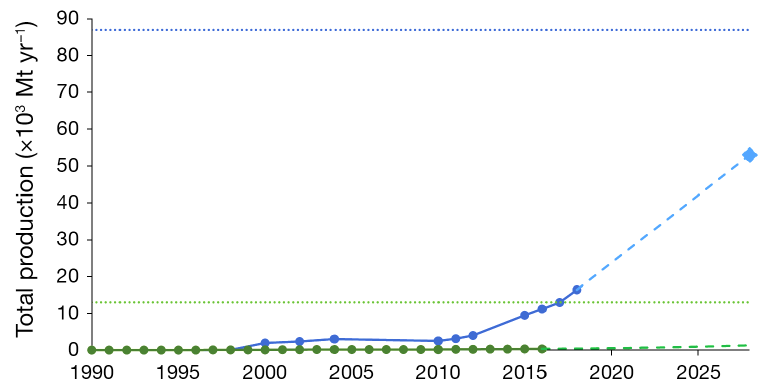
Fig. 4. Developments of tilapia (blue) and crocodile (green) aquaculture production in Lake Kariba. Solid lines indicate estimated total production as calculated from historical data, dashed lines indicate predicted total produc- tion based on growth expectations, dotted horizontal lines: total sustainable